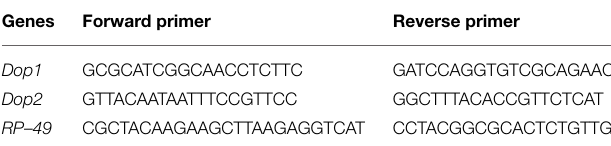
TABLE 1 | Primer sequences for quantitative